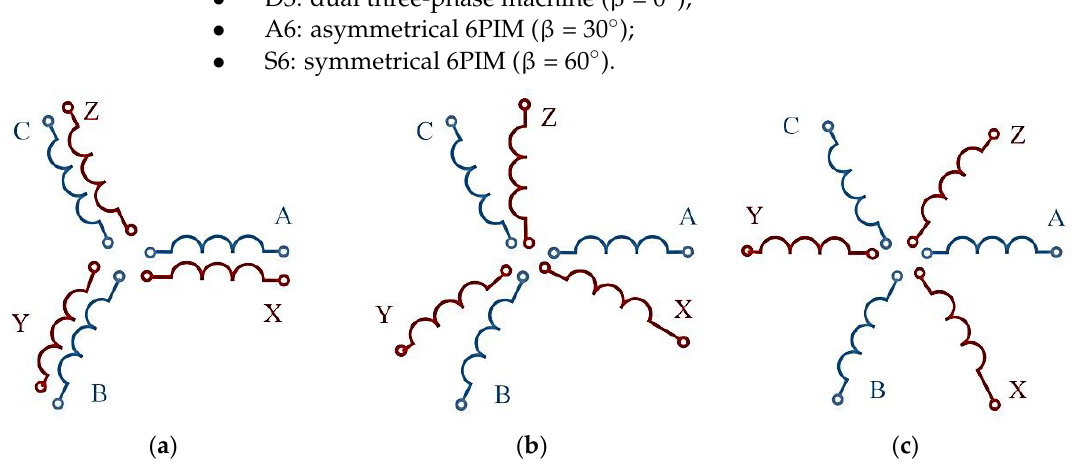
Figure 1. Dual three-phase induction machine D3 for β = 0° ( a ); asymmetrical six-phase induction machine A6 for β = 30° ( b ); symmetrical six-phase induction machine S6 for β = 60° ( c